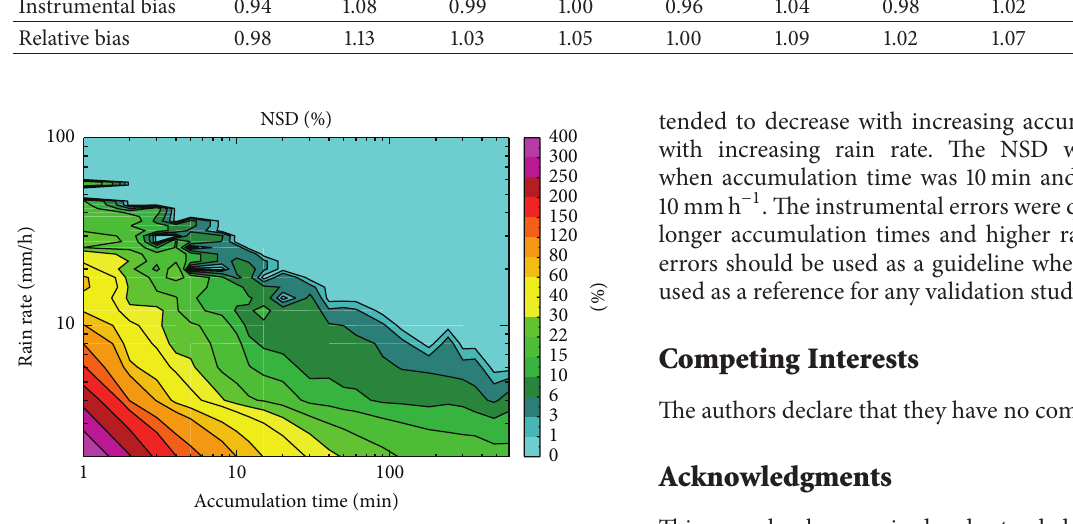
Figure 22: Two-dimensional normalized standard deviation between the standard rainfall and each rain